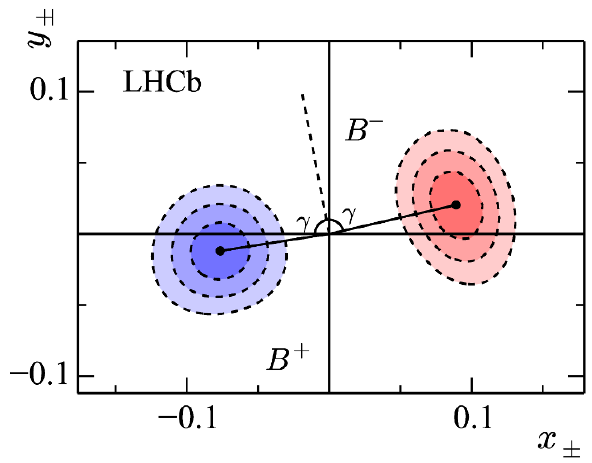
Figure 7 . Con(cid:12)dence levels at 68.2%, 95.5% and 99.7% probability for ( x + ; y + ) and ( x (cid:0) ; y (cid:0) ) as measured in B (cid:6) ! DK (cid:6) decays (statistical uncertainties only). The parameters ( x + ; y + ) relate to B + decays and ( x (cid:0) ; y (cid:0) ) refer to B (cid:0) decays. The black dots show the central values obtained in the